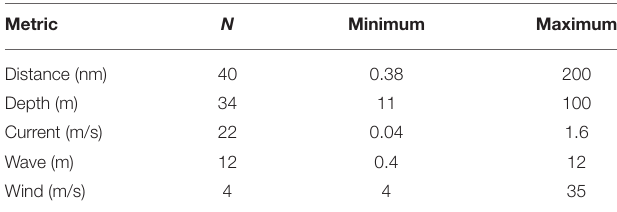
TABLE 1 | List of metrics and the number of articles ( N ) that provide that particular numeric measure.